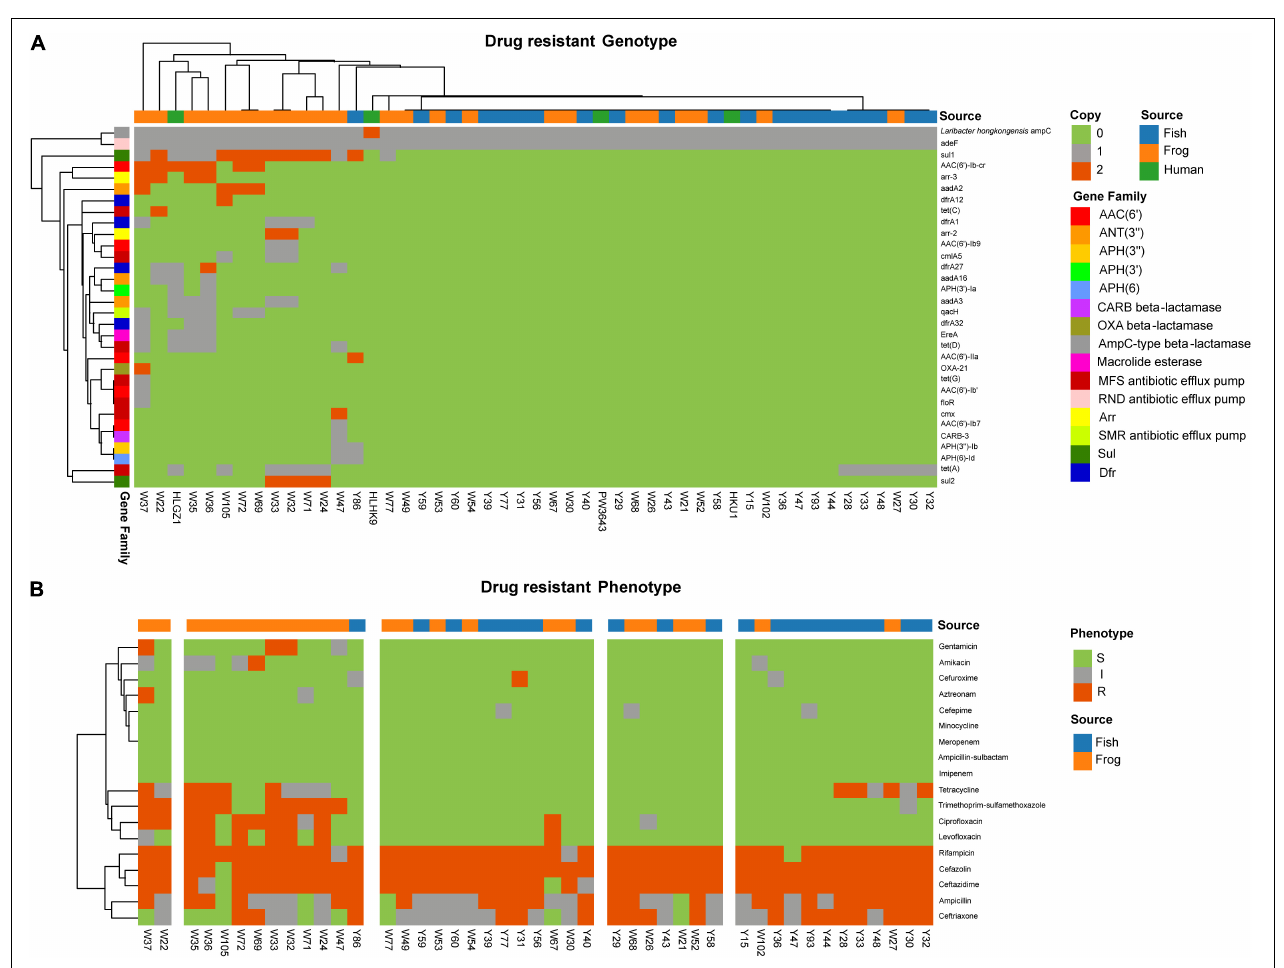
FIGURE 5 | Antibiotic susceptibility and genetic determinants for L. hongkongensis strains in this study. (A) Genetic determinants of 49 L. hongkongensis were displayed in a Complex heatmap. The source of strains, gene copies, and gene families are represented as colored bars. (B) Antibiotic susceptibility of 45 aquatic animal isolated strains was displayed, with S indicating susceptible, I indicating intermediate, and R indicating